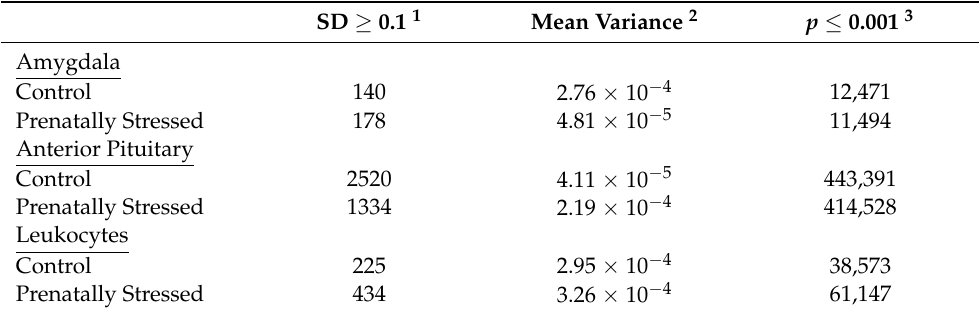
Figure 1. Pearson correlation coefficient estimates of samples (animals) using the beta values of cytosine-phosphate-guanine sites across the genome in the ( A ) Control amygdala, ( B ) Prenatally Stressed (PNS) amygdala, ( C ) Control anterior pituitary ( D ) PNS anterior pituitary ( E ) Control leukocytes, and ( F ) PNS leukocytes. Table 1. Number of cytosine-phosphate-guanine with high variability in DNA methylation within treatment groups and